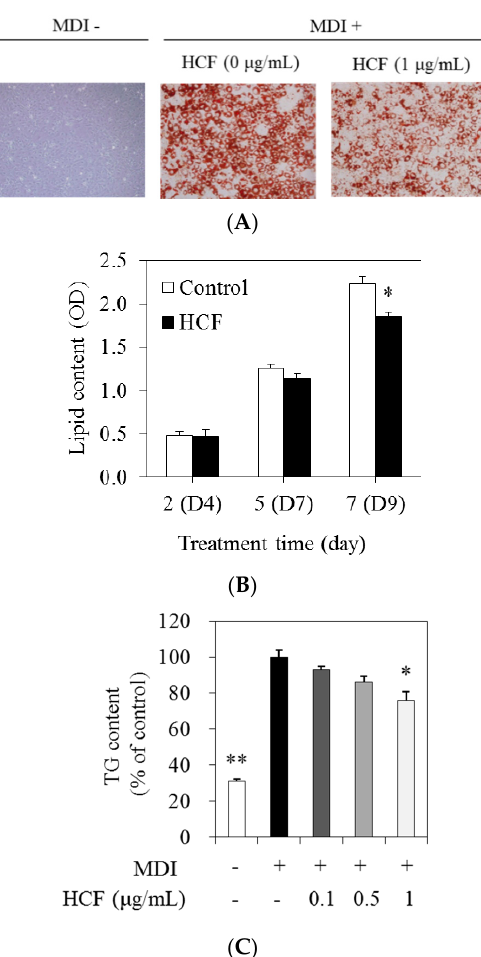
Figure 3. Effects of HCF on lipid accumulation and TG content during 3T3-L1